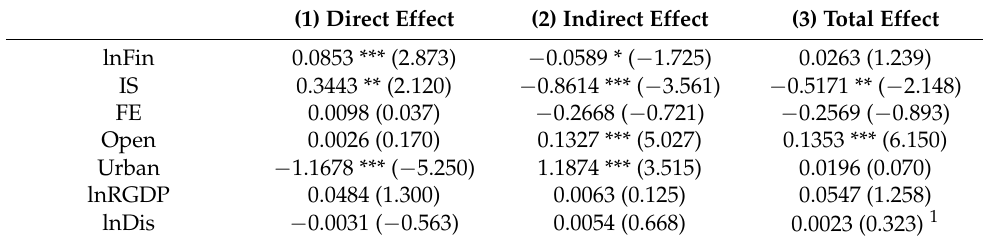
Table 9. The results of direct effect, indirect effect, and total